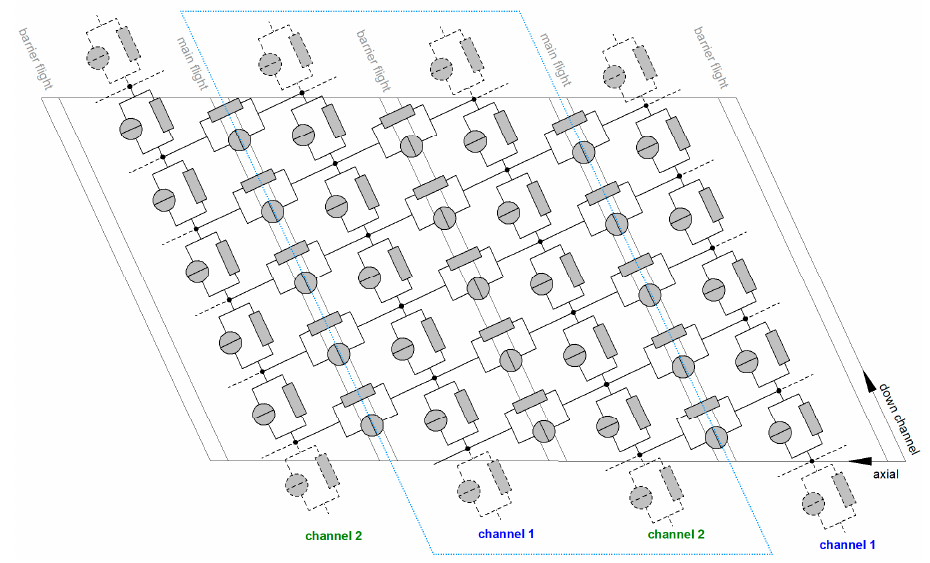
Figure 9. Network discretization of an unwound double-wave zone consisting of (i) two subchannels, (ii) two main flights, and (iii) a barrier flight. The network elements in the down- and cross-channel directions are connected via nodal points.